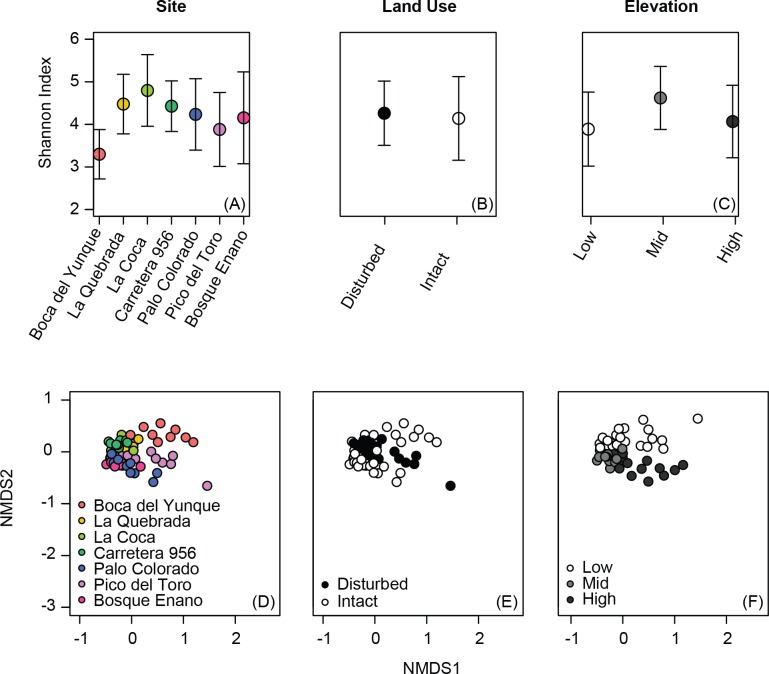
Variation in alpha diversity (A–C) and beta diversity (D–F) of the bacterial communities on the skin of Coqui frogs (Eleutherodactylus coqui) from seven sites varying in elevation and land use. Analyses of elevation (C, F) exclude one unpaired site from the highest elevation zone (Bosque Enano).Ordinations were constructed using non-metric multidimensional scaling based on Jaccard dissimilarities of relative abundance data (stress = 0.15 for D, E and also 0.15 for F).